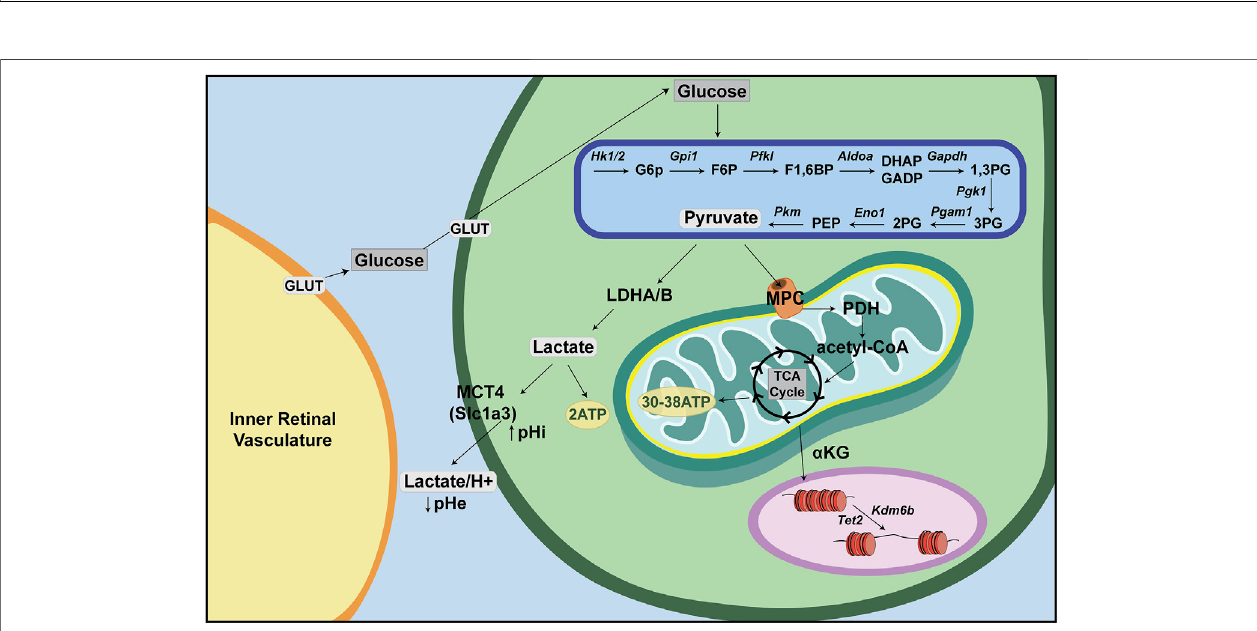
FIGURE2| Energymetabolism — aretina-centricview.Glucoseissuppliedtoinnerretinal cellsthroughtheinnerretinalvasculatureandtophotoreceptorsthrough the choroidal vasculature. Glucose then enters retinal cells through GLUT transporters and is metabolized in anaerobic conditions through a multistep process called glycolysis. Glycolysis produces pyruvate, which can be converted to lactate and transported out of the cell via lactate/H + symporters (Slc16a). In aerobic conditions, pyruvate is instead shuttled into the mitochondria where it is converted to acetyl-CoA to feed the tricarboxylic acid (TCA) cycle (or Krebs cycle). Acetyl-CoA is oxidized in a series of steps to make ~30 – 38 ATP via oxidative phosphorylation (OXPHOS).